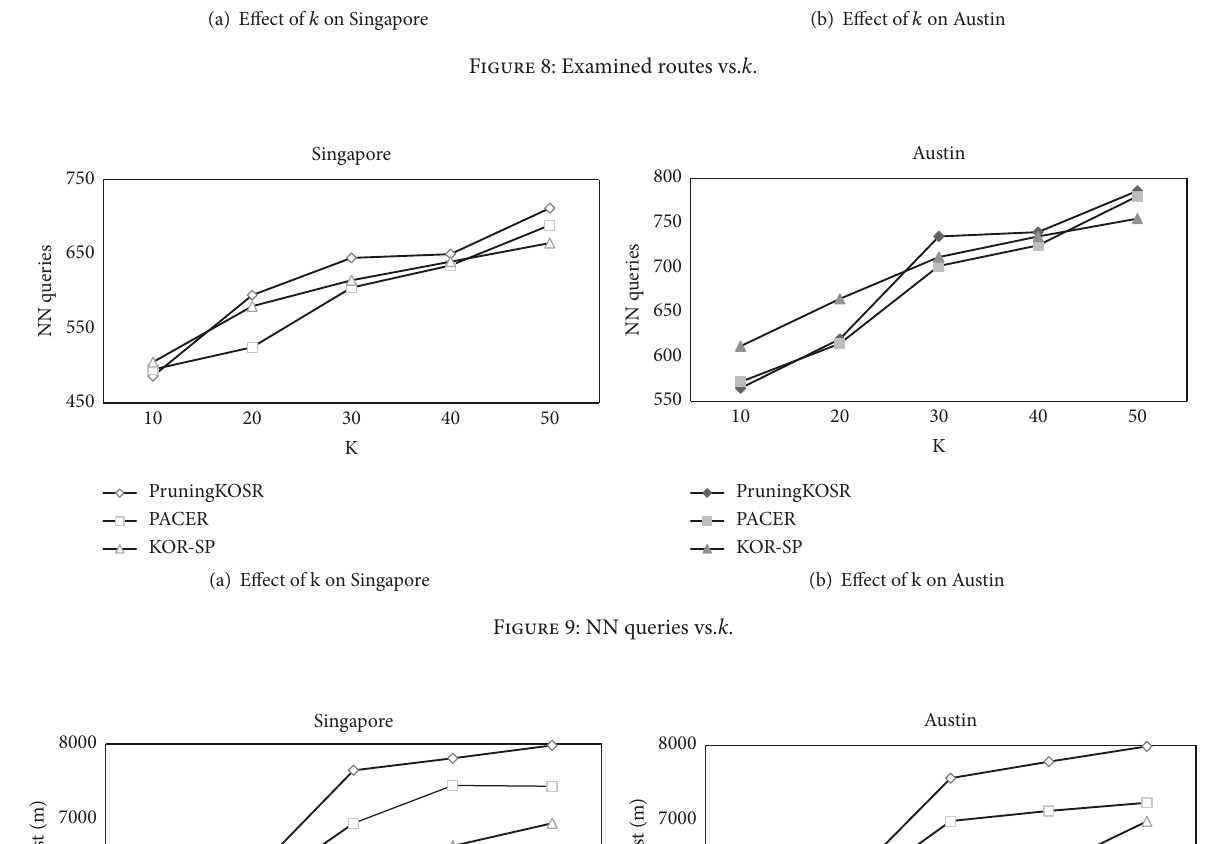
Figure 8: Examined routes vs. k .